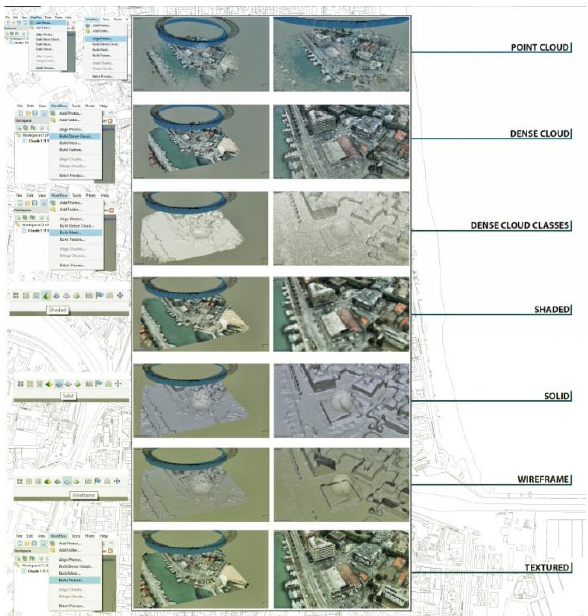
Figure 1: photogrammetric survey steps done with Photoscan by acquiring data from Google Earth with photocentric camera shots. textures and animated shaders, compatible to be imported on current virtual platforms equipped with advanced rendering engines, as Unreal Engine 4.20 or Unity, useful to obtain visual effects of photorealism and a three-dimensional interactive exploration (Cummings and Bailenson,